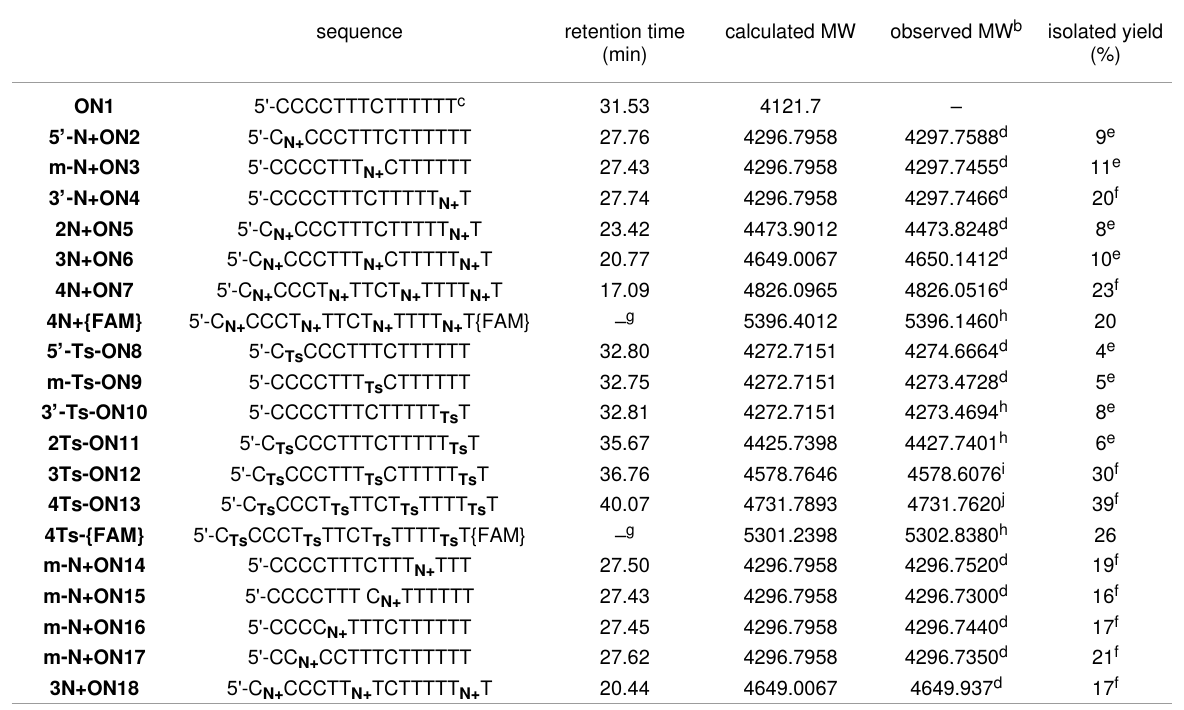
sequence retention time